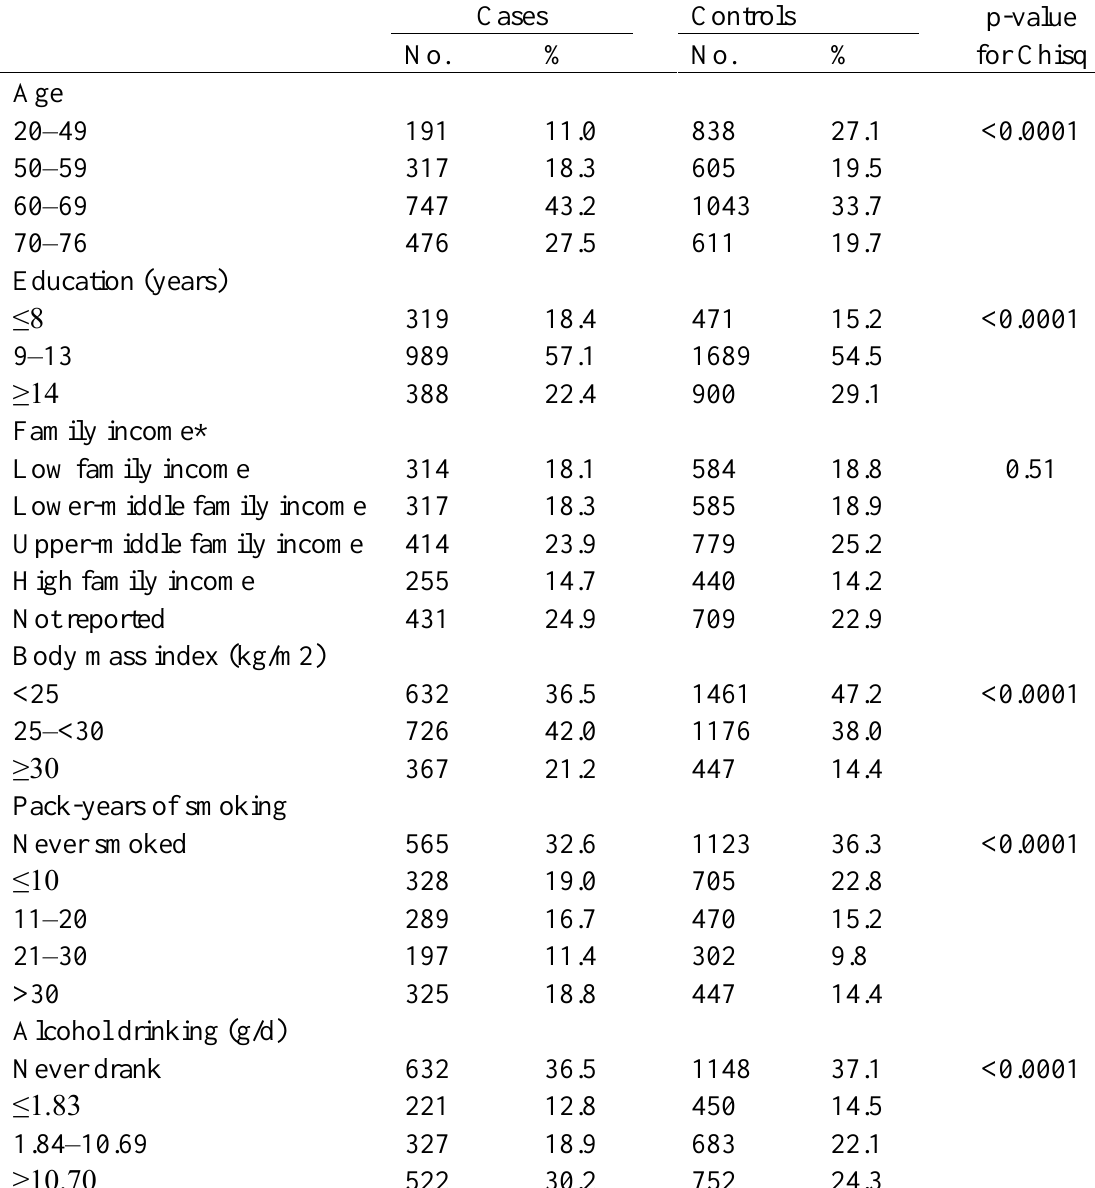
Table 1. Description and Chi square of selected covariates for 1731 colon cancer cases and 3097 population-based controls, NECSS, Canada,